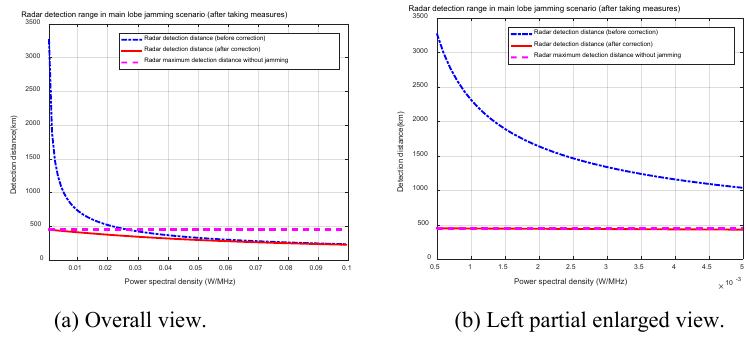
Fig. 4. Comparison of radar detection distance curves after taking anti-jamming measures.